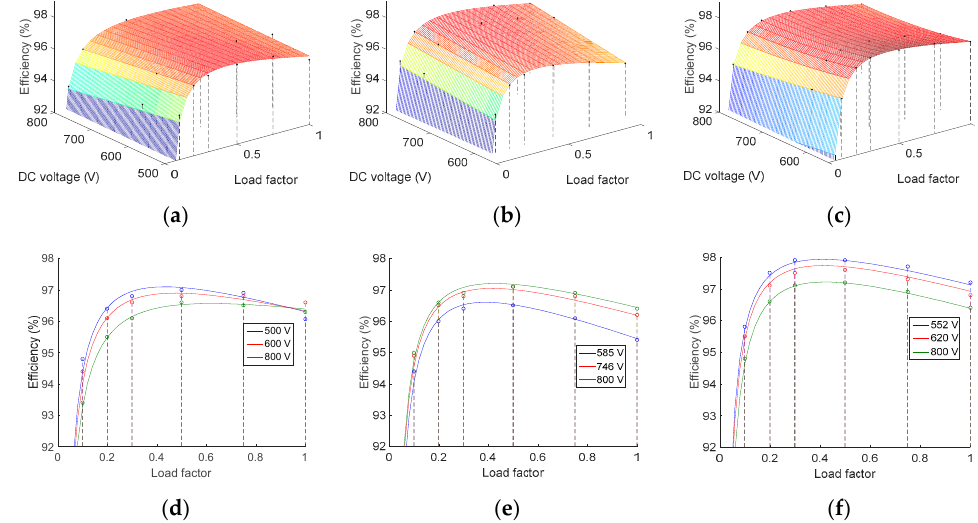
Figure 8. Efficiency surfaces and detail of curves for three values of the DC voltage calculated by means of the Sandia model. ( a ) and ( d ) Perfect Galaxy International Ltd EQX0250UV480TN. ( b ) and ( e ) Power-One ULTRA-750-TL-OUTD-4-US. ( c ) and ( f ) Power Electronics FS0900CU.